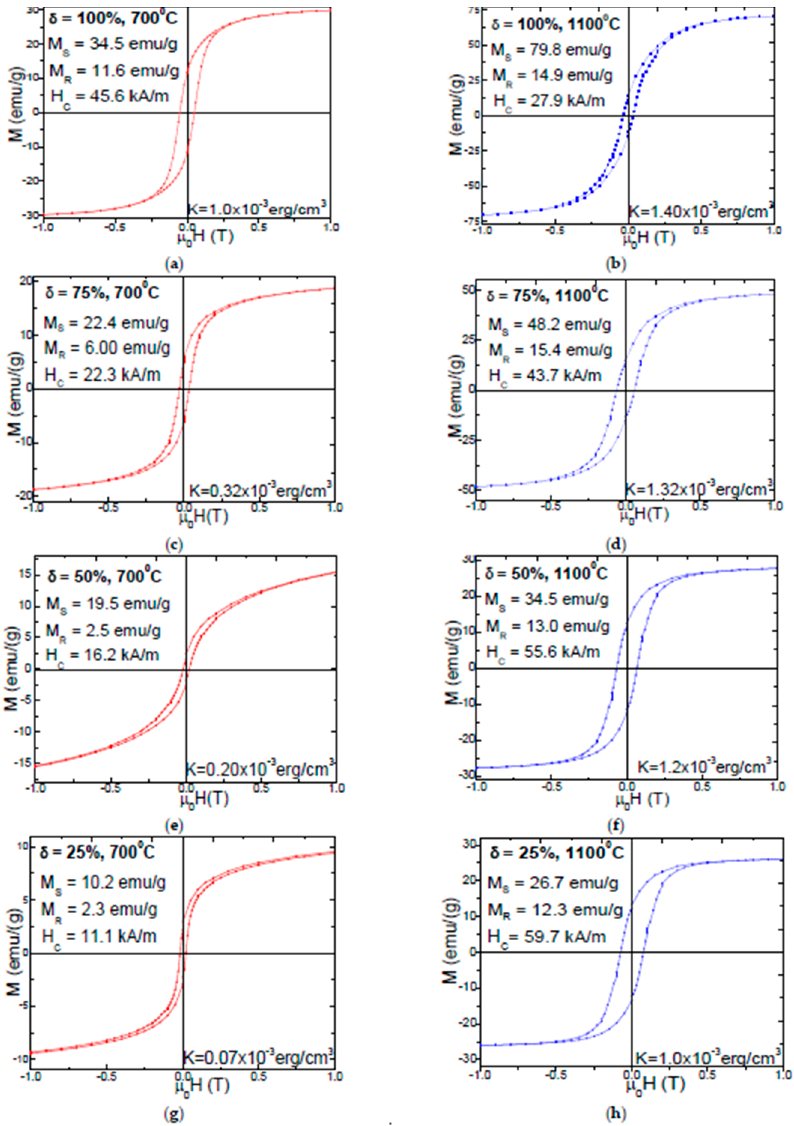
Figure 4. Magnetic hysteresis loops of (Zn 0.6 Mn 0.4 Fe 2 O 4 ) δ (SiO 2 ) 100 − δ ( δ = 100% ( a , b ), 75% ( c , d ), 50% ( e , f ) and 25% ( g , h )) NPs calcined at 700 and 1100 °C.